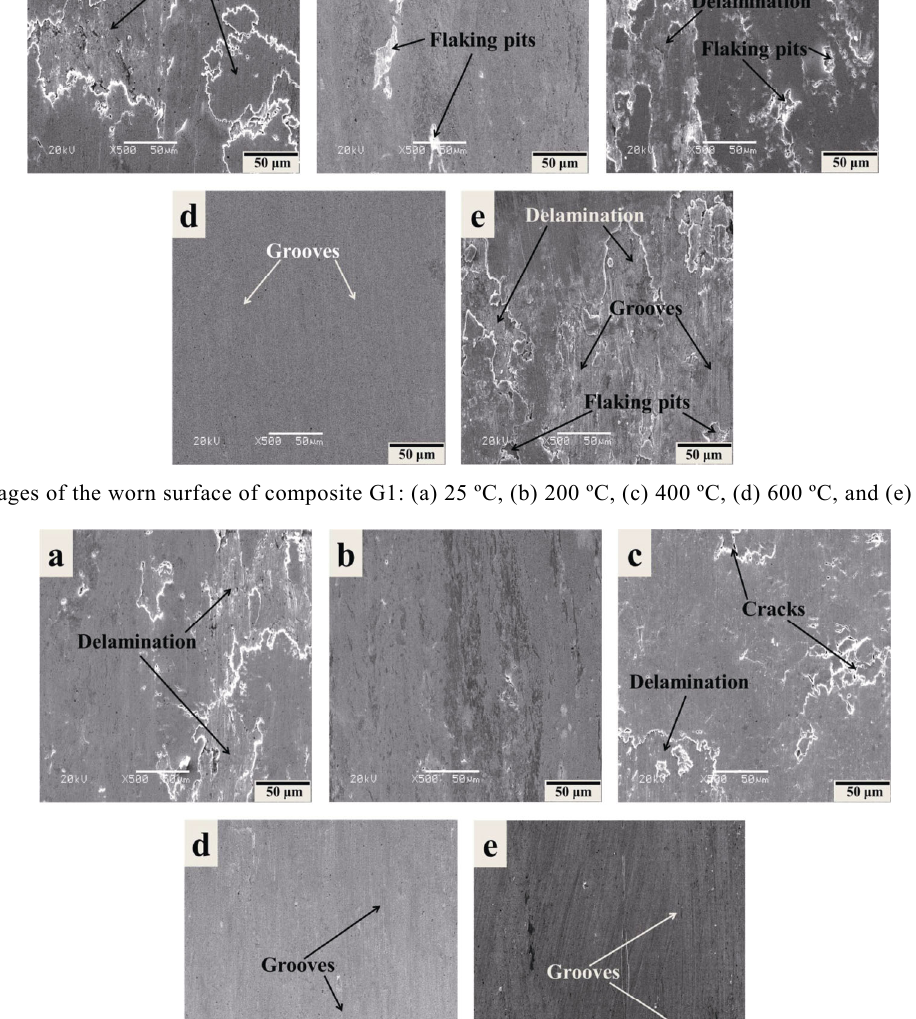
| https://mc03.manuscriptcentral.com/friction